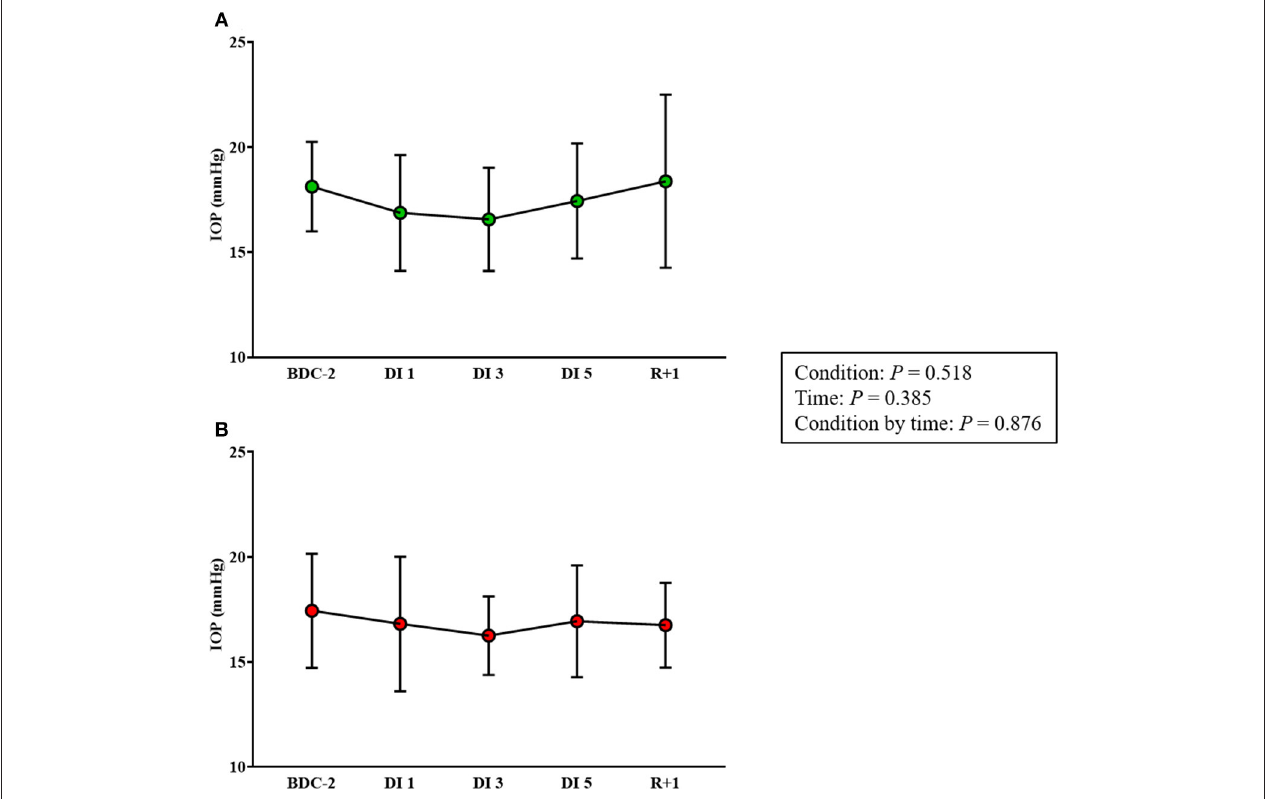
FIGURE 7 | Intraocular pressure (IOP) measurements before, during, and after DI in control (A) and cuffs (B) groups. BDC-2, 2 days before DI; DI 1, first day of DI; DI 3, third day of DI; DI 5, fifth day of DI; IOP, intraocular pressure; R + 1, first day after DI.